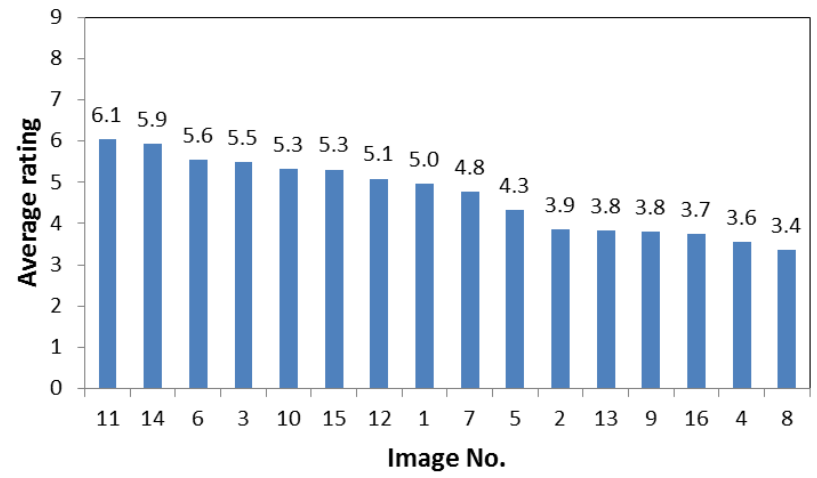
Figure 3. Average rating for question 4: visual richness of the pictures.